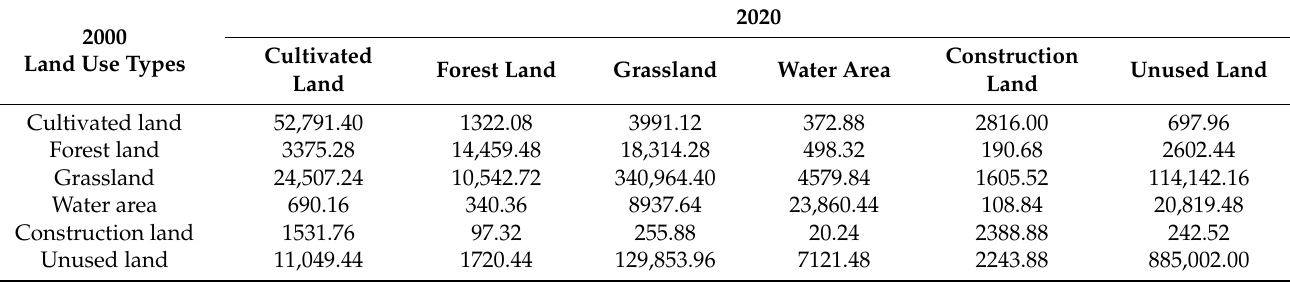
Table 3. Land use area transition matrix in Xinjiang from 2000 to